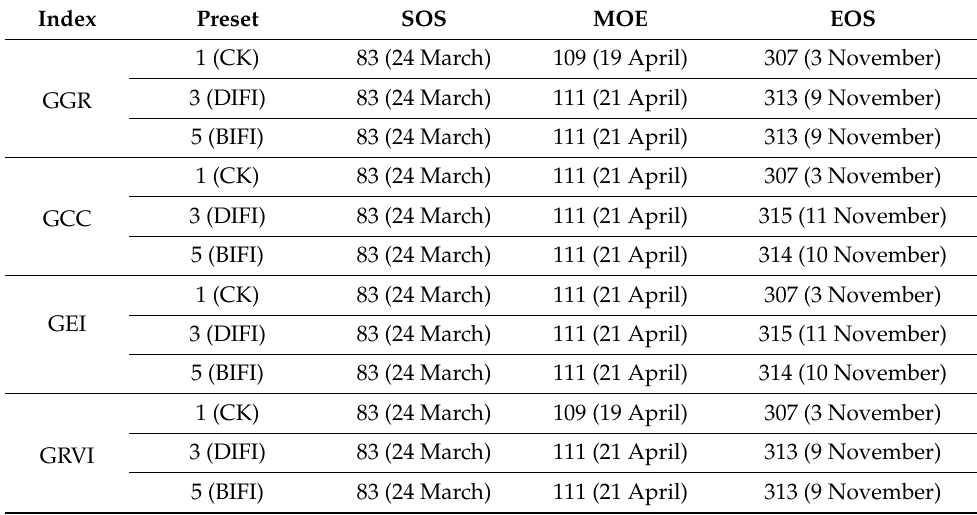
Table 4. Growth of the same vegetation index at different preset